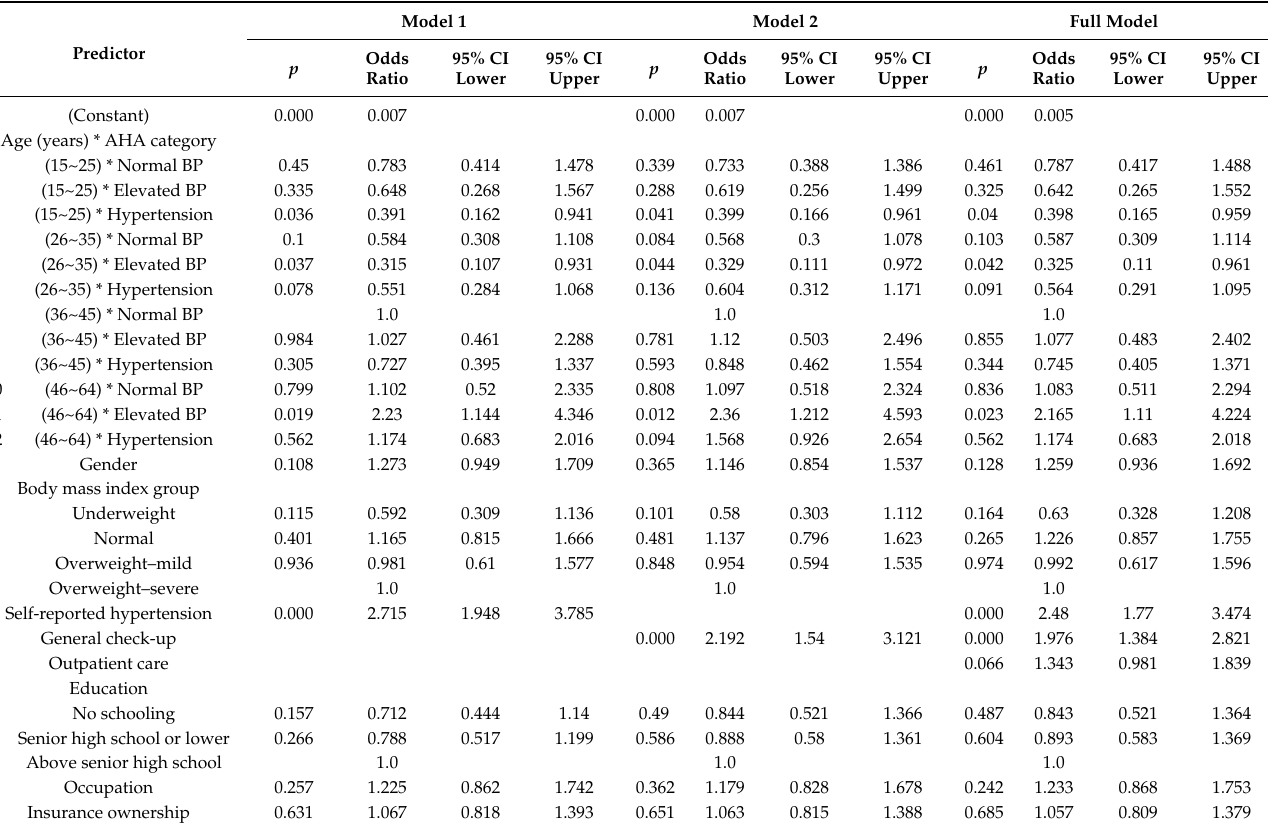
Table 3. Multivariate logistic regression analysis of hearing